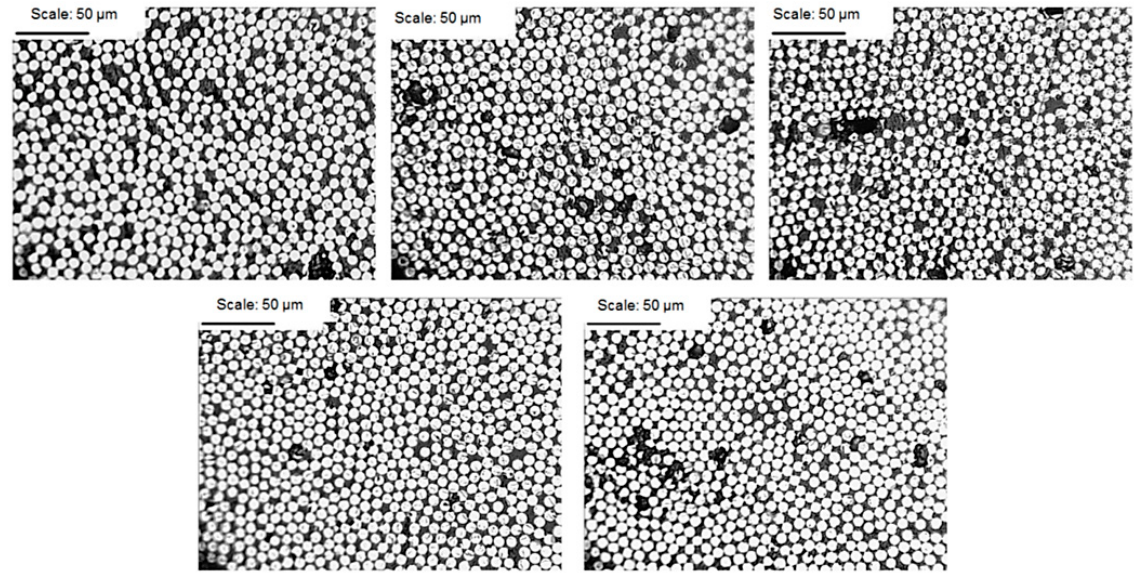
Figure 10. CFRP composite microstructure photomicrographs; magnification of 500× for samples 1–5.